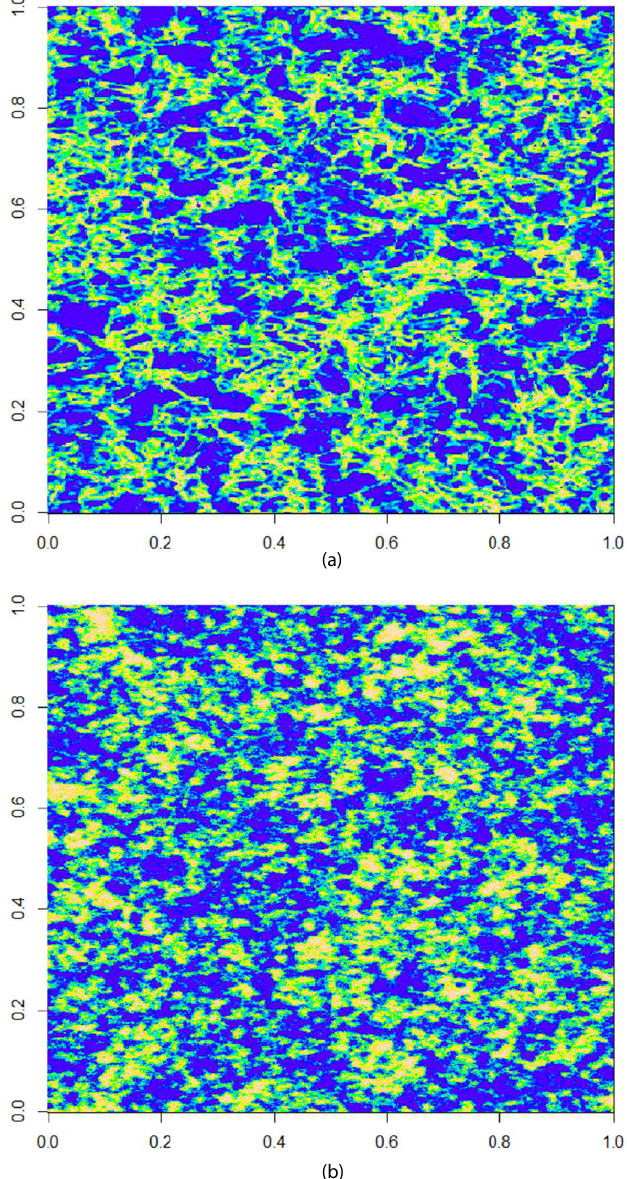
Fig. 4. (a) Example of a real microstruture to be modelled and simulated. (b) Example of a simulation coming from a Gaussian geostatistical method applied on data in